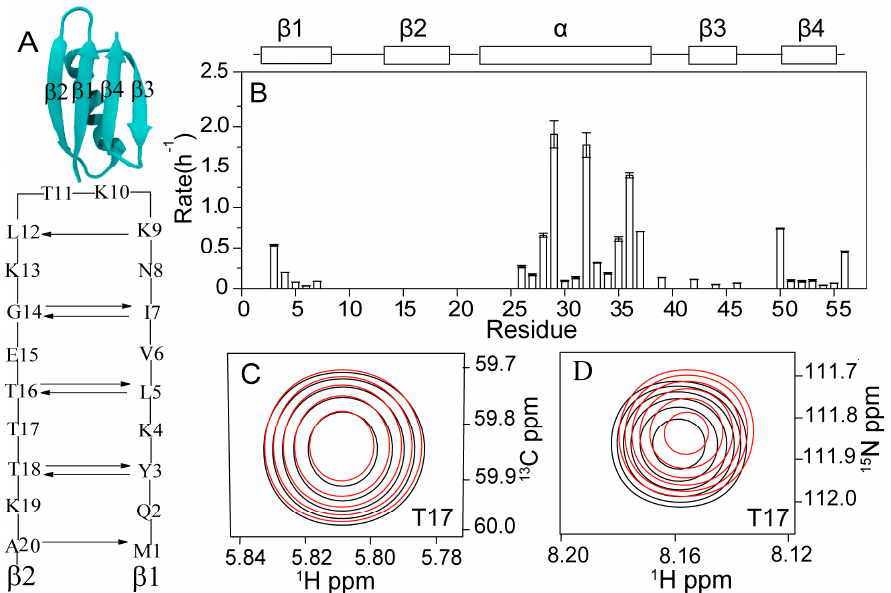
Figure 1. ( A ) H-bonding interactions between β 1 and β 2 of GB3. ( B ) H/D exchange rates versus residues of protein GB3 measured at pH 6.4, 298 K, in 100% D 2 O. The residues without rates have fast exchanges ( k ex > 5 h − 1 ). The exchange rates are also listed in Table S1. Overlay of the first and last ( C ) 1 H- 13 C and ( D ) 1 H- 15 N HSQC spectra of residue T17 shows that its backbone chemical shifts of 1 H α , 13 C α , 1 H N , and 15 N change in the H/D exchange process (black, the first spectrum measured at 0.5 h; red, the last spectrum measured at 12 h). Since T17 and all other residues in β 2 have fast H/D exchanges, these chemical shift changes are due to the H/D exchange of the amides in β 1. The profiles of the chemical shift changes are shown in Figure 2.